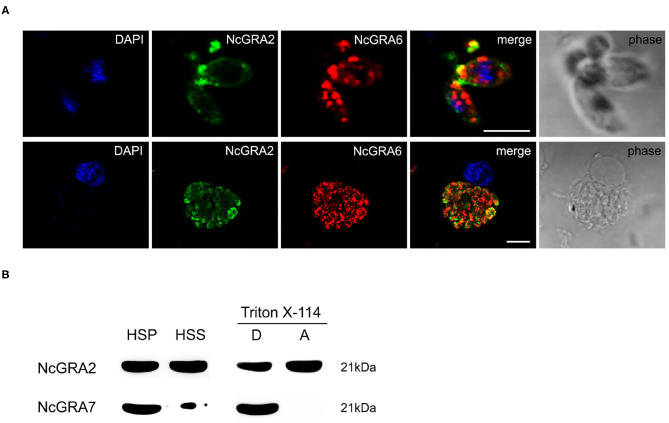
Subcellular localization and morphology analysis of the NcGRA2 protein in parasites and infected cells. (A) Immunofluorescence colocalization of NcGRA2 and NcGRA6 proteins in parasites and infected cells. The nucleus was stained with DAPI. The NcGRA2 protein and NcGRA6 protein were labeled with FITC and Cy3, respectively. Bar = 5 μm. (B) Morphology analysis of the NcGRA2 protein in parasite-infected cells. HSS represents the soluble cell fraction after high-speed centrifugation. HSP represents the insoluble cell fraction after high-speed centrifugation. The HSPs were then sonicated and centrifuged at high speed, and pellets (P) and supernatants (S) were obtained. The obtained pellets were further dissolved in denaturing agents, and the detergent phase (D) and aqueous phase (A) were obtained. The NcGRA7 protein was used as a control to detect the purity of fractions.